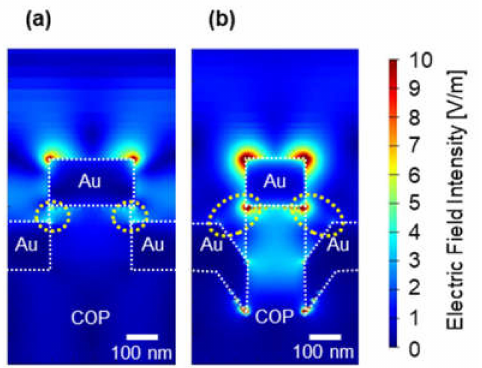
Figure 13. Electric field distribution ( a ) at the 615 nm wavelength for (A) and the 150 nm Au thickness and ( b ) at the 645 nm wavelength for (C) and the same Au thickness. The yellow dashed circles indicate the area where the electric field distribution changed due to pit